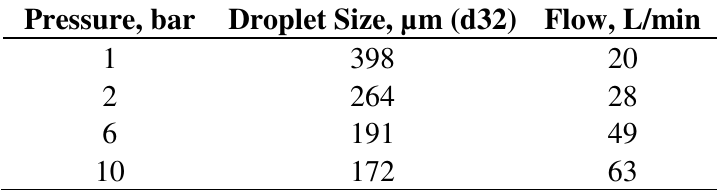
Table 3. Pressure vs. droplet size in a standard 7-orifice cluster nozzle